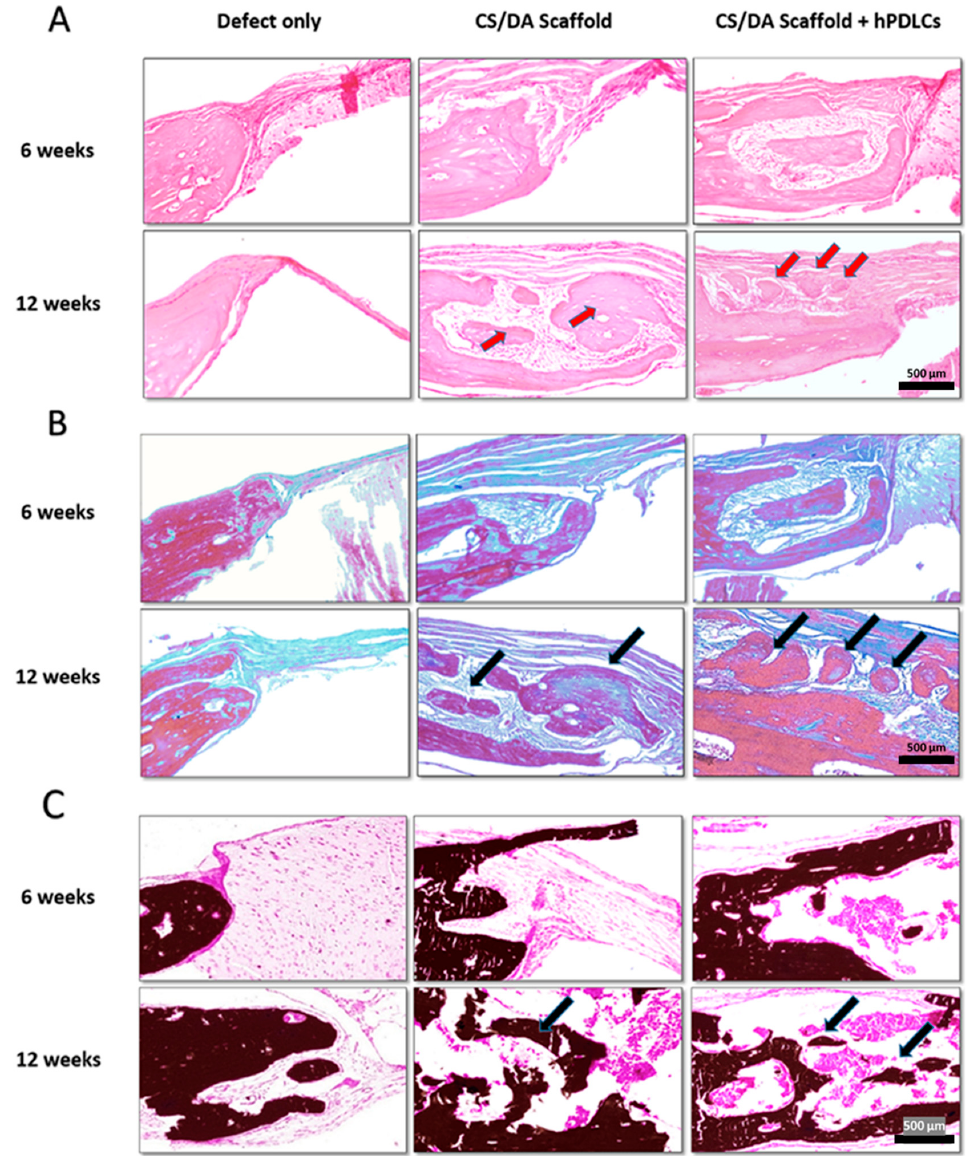
Figure 5. Effect of CS/DA scaffold on bone regeneration in mouse calvarial defects as assessed by histology (×20). ( A ) H&E staining shows newly formed bone and dense connective tissue (red arrows) in the group of CS/DA scaffold implanted with hPDLCs and in the group of CS/DA scaffold alone. ( B ) Masson’s trichrome staining of CS/DA scaffold with and without hPDLCs after 12 weeks showed an increase of blue color representing collagen and mineralized matrix (black arrows). ( C ) Undecalcified sections with Von Kossa staining of both scaffold alone group and scaffold with hPDLCs group showing intense black mass representing mineralized matrix (black arrows).